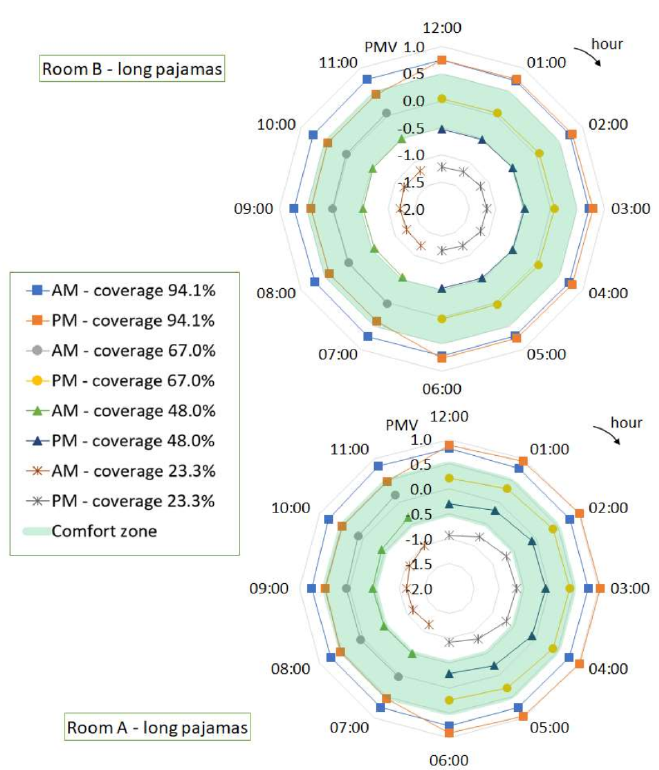
Figure 18. Hourly PMV of bedridden patient: different coverage rate in the winter